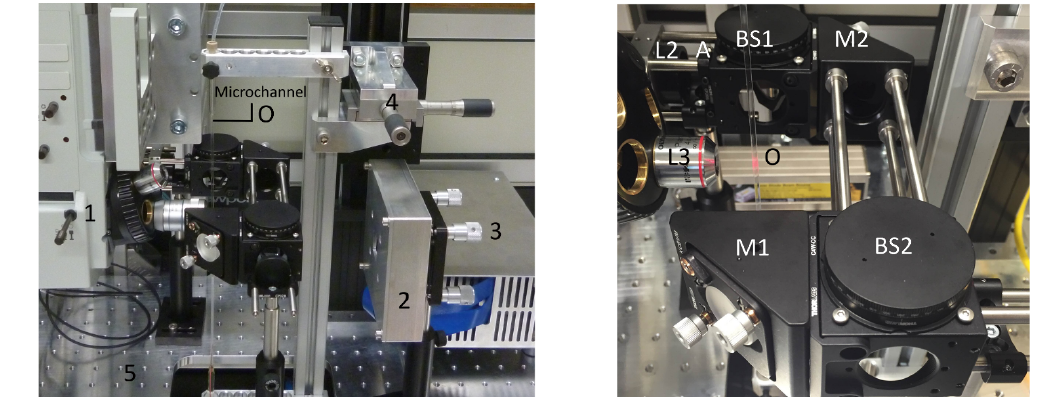
Figure 6. The experimental set-up for the combined Mach–Zehnder holography and confocal Raman-spectroscopy sensor system to inves- tigate the bubble dynamics and the localised concentration measurement simultaneously in a Taylor flow.